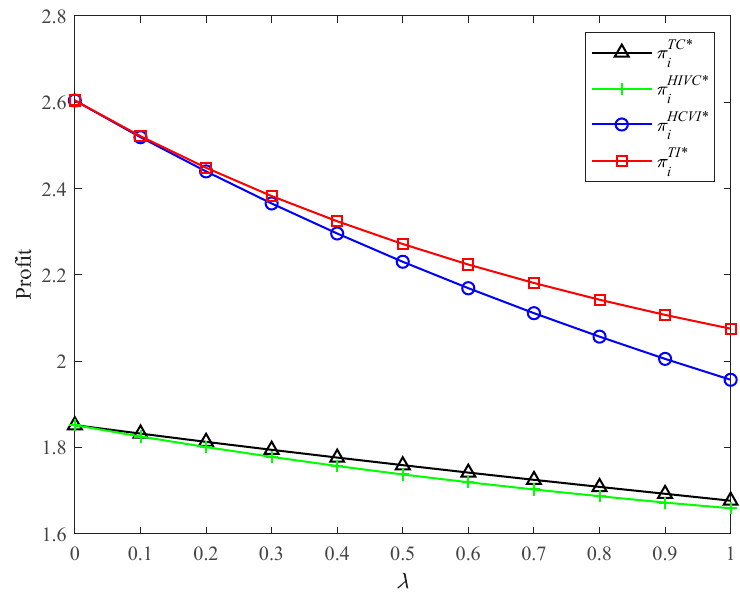
Figure 5. Profits in four models with different λ .